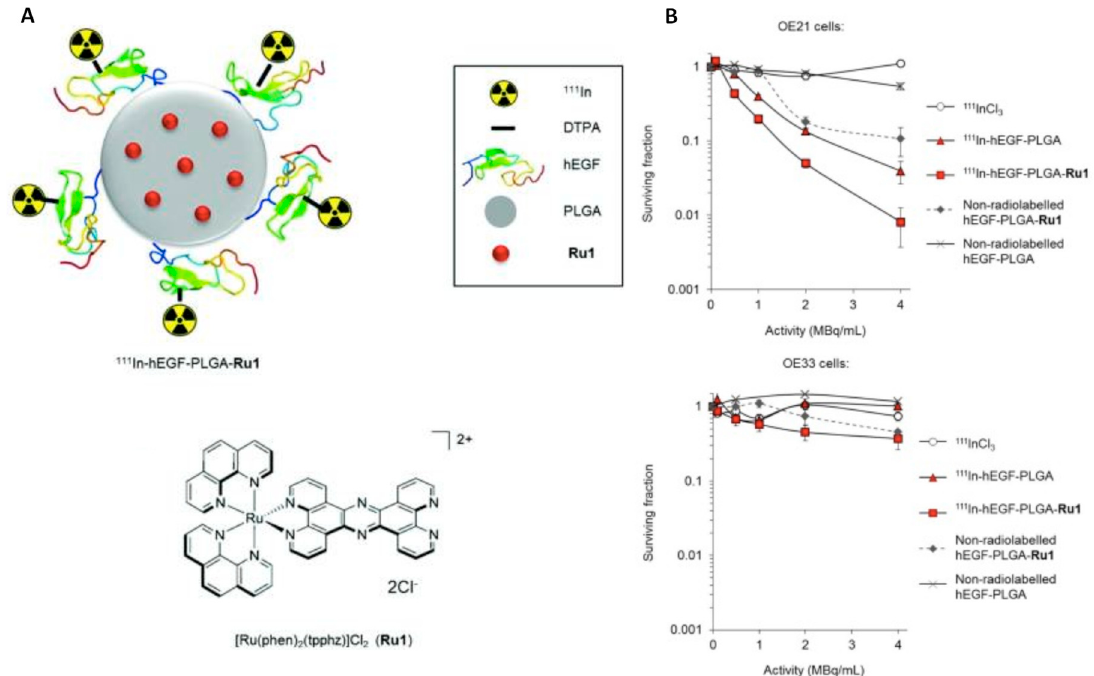
Figure 3. ( A ) The ruthenium(II) metallo-intercalator and radiosensitizer, Ru1 , is encapsulated within Poly(lactic- co -glycolic) acid (PLGA) core and nanoparticles are surface labeled with 111 In-DTPA-hEGF, bottom—chemical structure of Ru1 . ( B ) Clonogenic survival assays of OE21 or OE33 cells exposed to 111 In radiolabelled hEGF-PLGA nanoparticles with or without Ru1 -loading (24 h incubation time). Non-radiolabelled nanoparticles (in equivalent concentrations; 0 to 1000 µ g mL − 1 ) and free 111 InCl 3 (in equivalent specific activity) are included as controls. Data points are the mean of triplicates ± S.D. Reprinted with permission from reference [70].